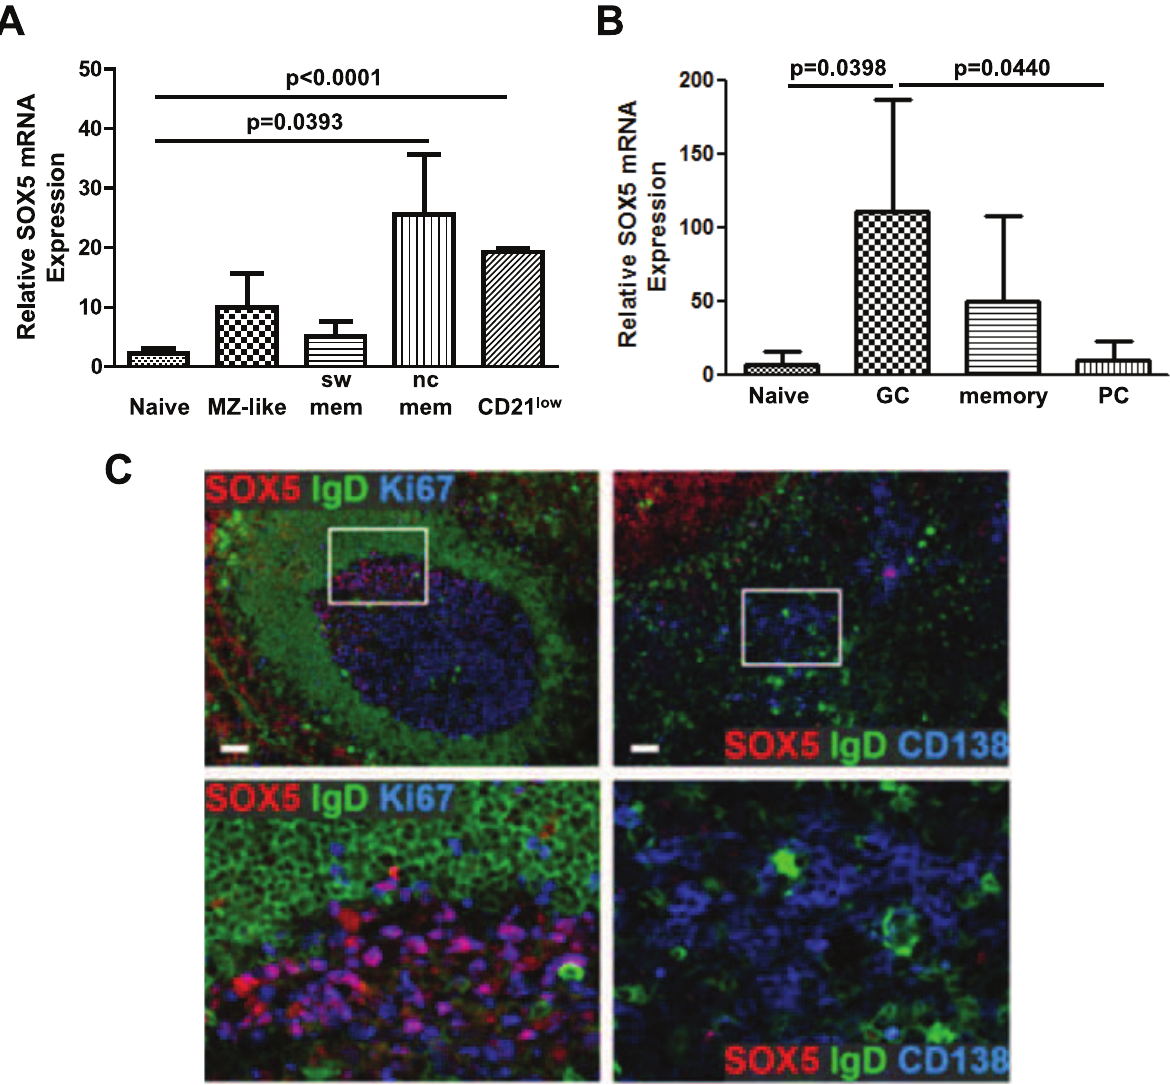
Figure 3. Expression of SOX5 in human B cell subpopulations. (A) Relative quantification of SOX5 by RT-qPCR in peripheral blood naive, MZ- like, switched memory (sw mem), non-classical memory (nc mem) and CD21 low B cells. (B) Relative quantification RT-qPCR assay for SOX5 expression in follicular naive, germinal center B cells (GC), memory B cells and plasma cells (PC) from tonsils. T-test p-values indicate the significance of differences between the samples. Relative expression levels of SOX5 are shown as mean 6 SD. RPLP0 gene was used as an internal control in the samples. (C) Immunofluorescence staining for the expression of SOX5 protein in tonsillar tissues. IgD staining was used to stain mantle zones, Ki67 staining for proliferating centroblasts within germinal centers and CD138 as a marker for extrafollicular plasma